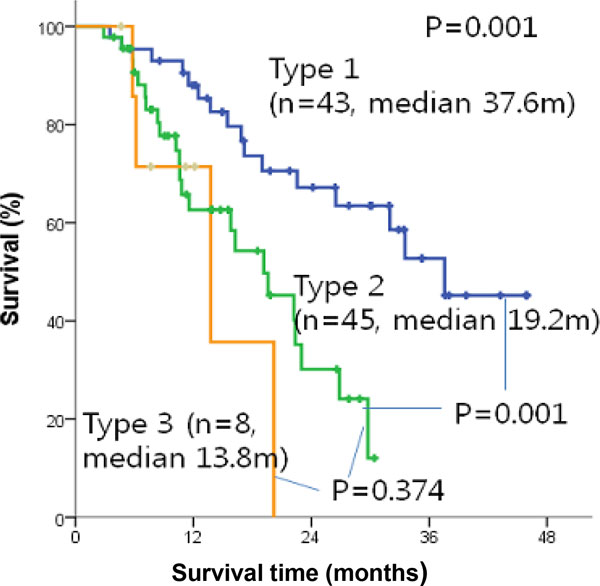
Kaplan-Meier survival curve. Kaplan-Meier survival curve comparing survival of individuals with subtype 1 (blue), subtype 2 (green), and subtype 3 (orange) with 0.001 p-value by log-rank statistics test.